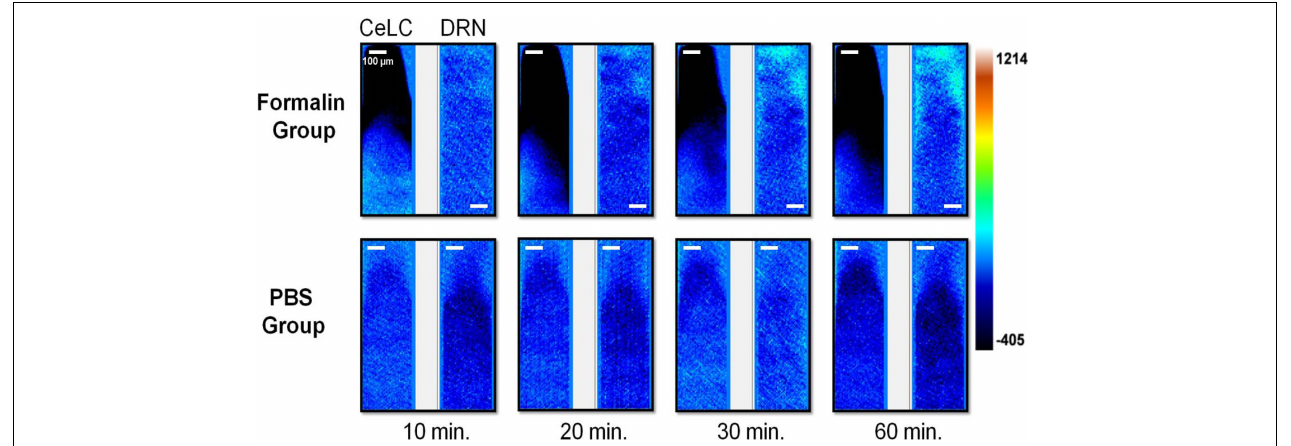
FIGURE 4 | Brain activity fluorescence immediately after injection of formaldehyde or PBS. Neuronal fluorescence from the replicates that demonstrated detectable and distinct signals are presented. Time shown refer to the minutes that has passed after injection of the assigned substance. For all image pairs, CeLC is on the left and the DRN is on the right. Heatmap values are voltage values that represent (cid:49) F.